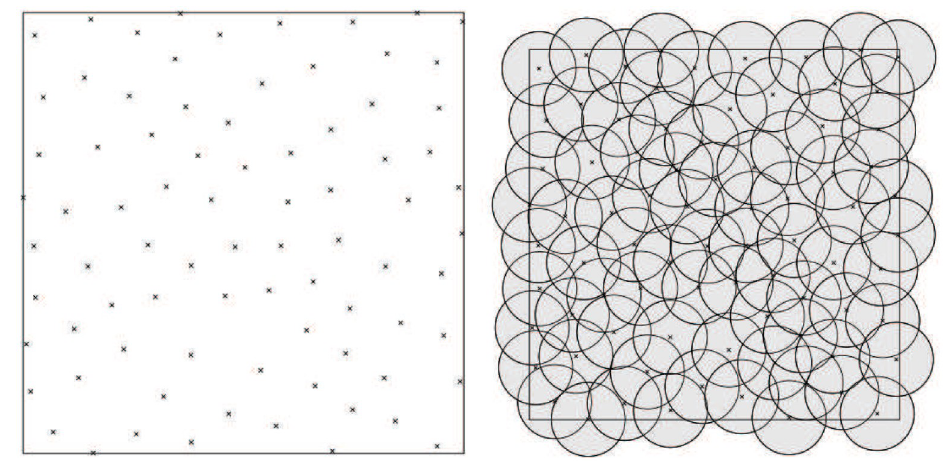
Fig 3. The principle of maximal Poisson-disk sampling [13]. The samples are hyper-uniformly distributed. The distance between any two samples is larger than the largest radius of the disks.